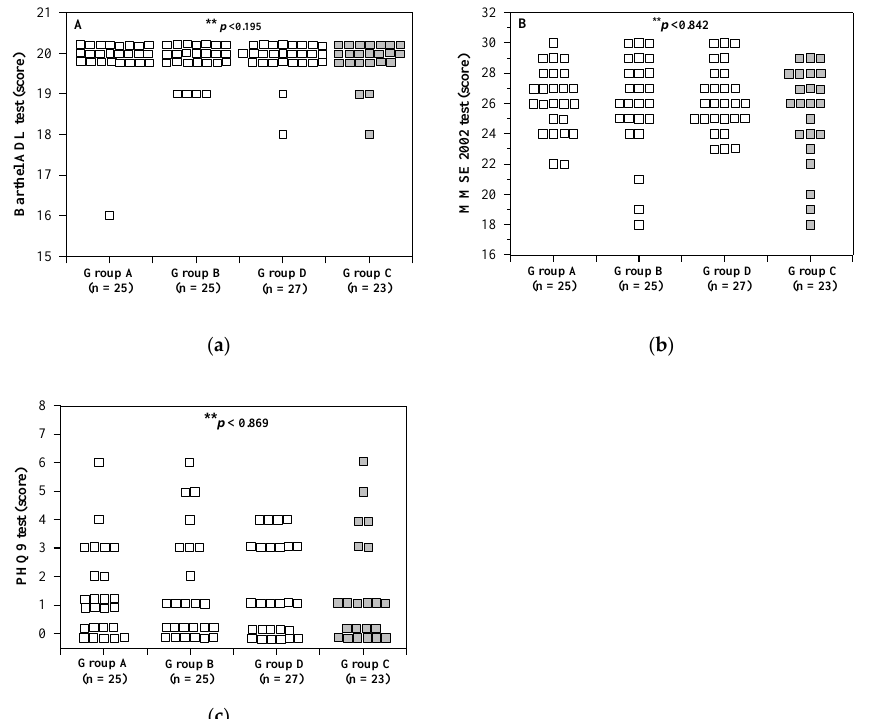
Figure 1. Numbers of subjects in groups A, B, D and C for Barthel ADL ( a ), MMSE Thai 2002 ( b ) and PHQ9 ( c ) tests before the study. Non-anemic elders consumed the WR drink (2 mg iron/100 mL serving) (group A), IR drink (15 mg iron/100 mL serving) (group B) and IR drink (27 mg iron/100 mL serving) (group D), while anemic elders consumed the IR drink (15 mg iron/100 mL serving) (Group C) for 30 days. Data of individual subjects are expressed accordingly. * Pearson chi-square test, ** Fisher’s exact test when members of the same group were compared. Abbreviations: ADL =